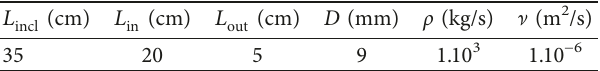
Figure 2: Geometry of the inclined walls. Table 1: Geometrical dimension and fluid property used in the